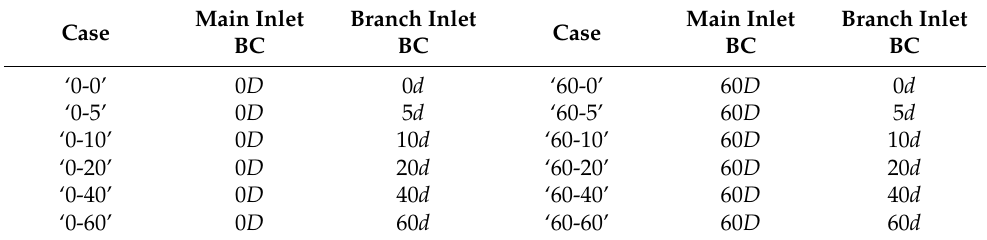
Table 1. Summary of inlet flow profiles of the BCs. Each simulation is identified with a pair of indices; the first index represents the inlet flow profiles used at the main T-junction inlet, and the second index refers to the inlet flow profiles applied to the branch T-junction